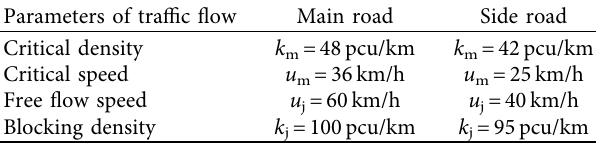
Table 1: Traffic flow parameters for East Youyi Road.